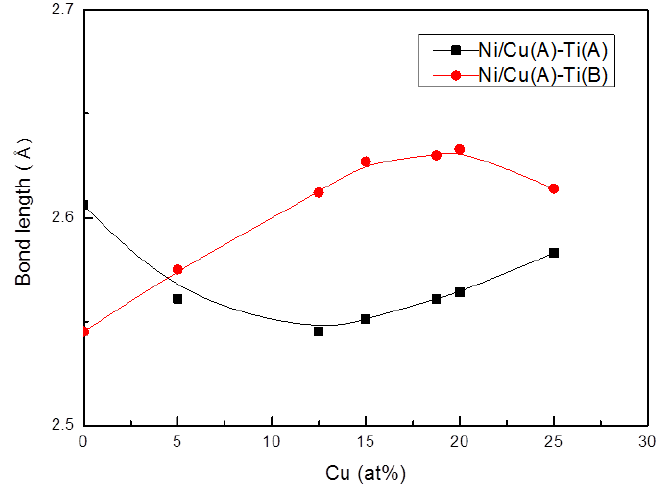
Figure 5. Variation of Ni/Cu–Ti bond length with Cu content. (See text for